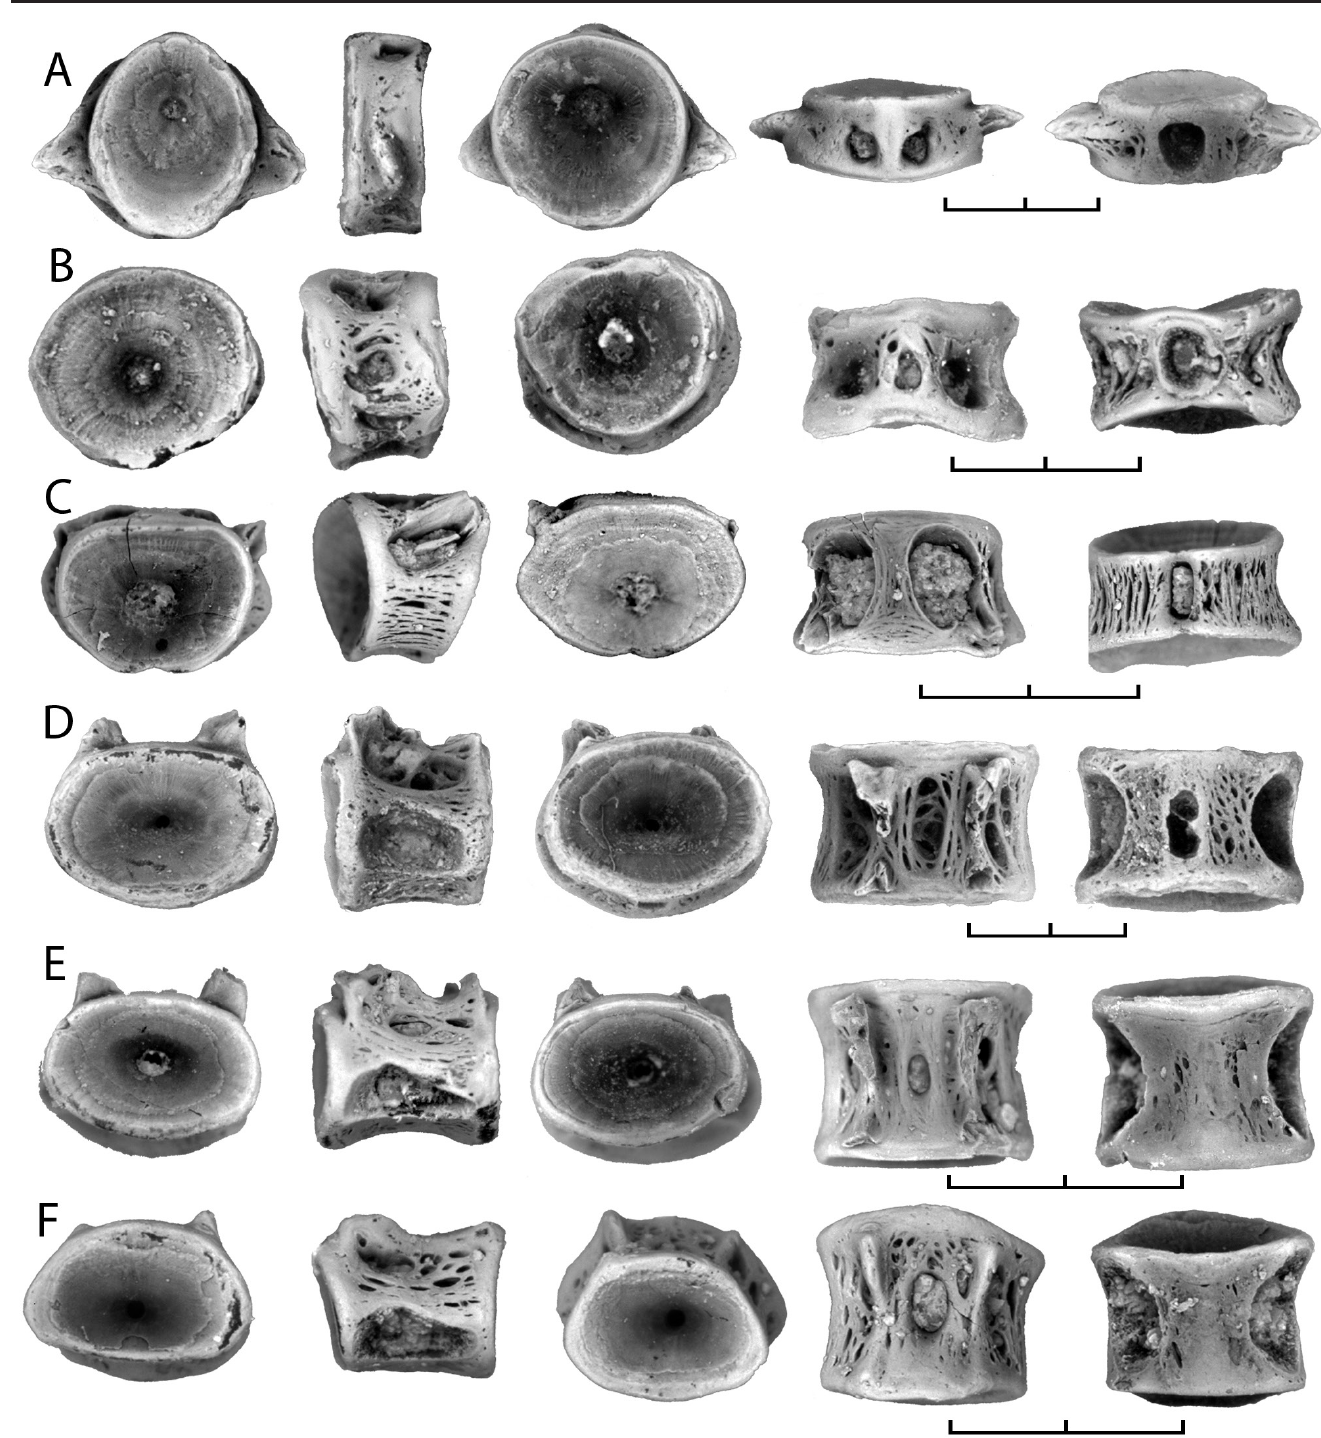
Figure 17. Centra of the presumed ostariophysan designated Teleost U-3/BvD from the Milk River Formation. A) First centrum of Weberian apparatus, TMP 2000.002.0059. B) anterior precaudal centrum, UALVP 48884. C) centrum tentatively identified as being from the Weberian apparatus, UALVP 48890. D) centrum transitional between anterior and mid-precau - dal centra in the development of parapophyseal pit and mid-ventral pit, TMP 2000.001.0067. E, F) mid-posterior precaudal centra showing variation in development of the mid-ventral pit: E, TMP 2000.002.0056; F, UALVP 48894. Centra shown in anterior, left lateral, posterior, dorsal and ventral views. Scale bar equals 2